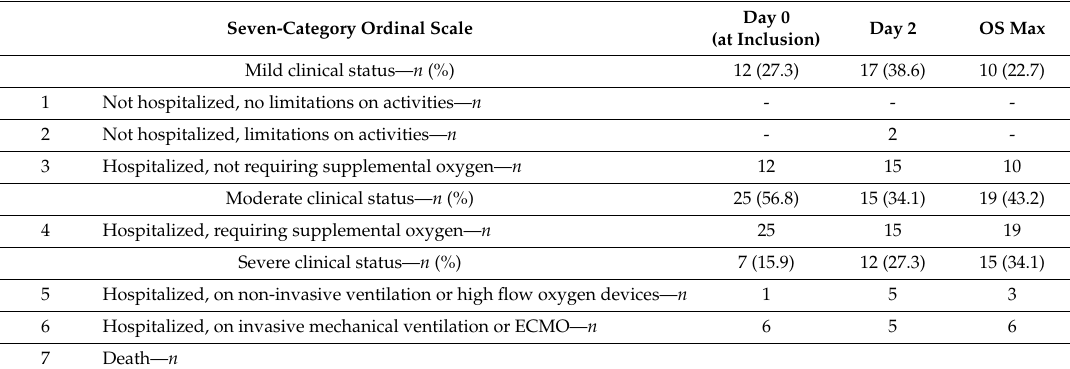
Table 2. Clinical course during hospitalization according to the Covid-19 ordinal scale (mild, moderate, severe